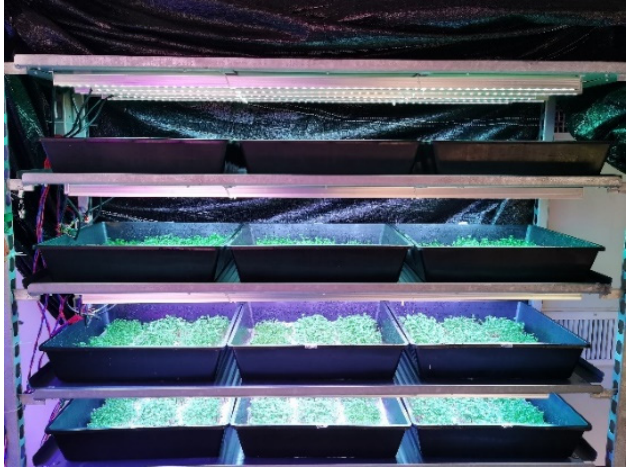
Figure 1. Photo of the experimental bench.